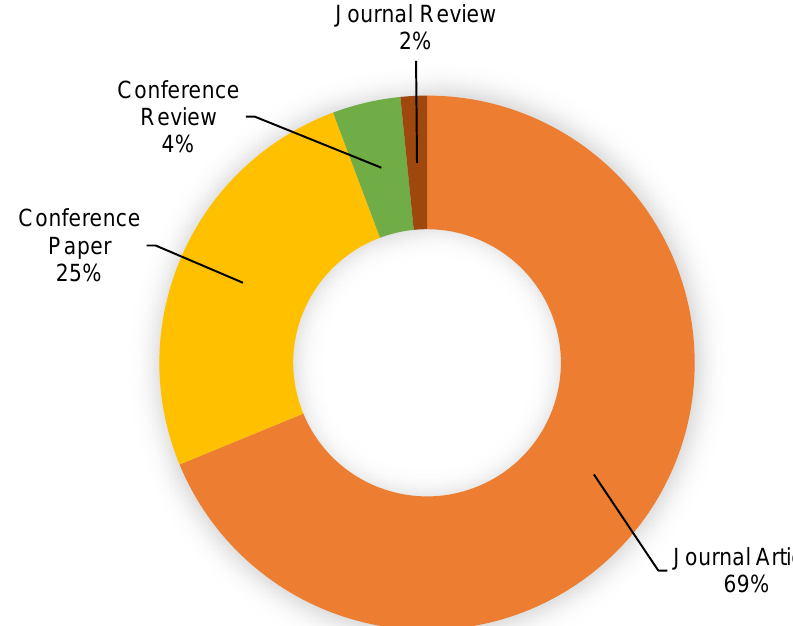
Figure 4. Article types published.